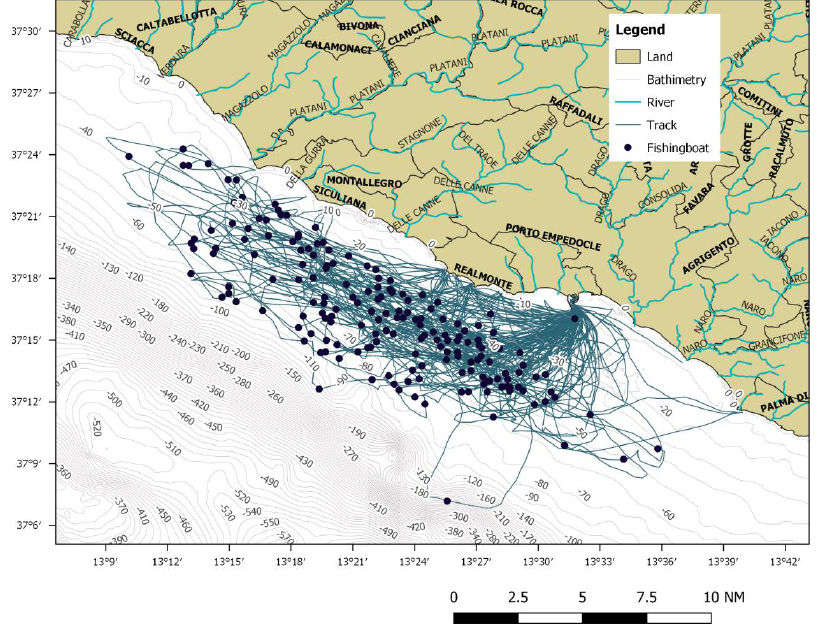
Figure 1. Geographical locations of fishing boats (blue dots, trawlers and pair trawlers) observed in the waters of the Agrigento province, in 2018 – 2019. Survey tracks are shown in light blue. Recorded sightings of seabirds were 674 for shearwaters and 92 for European storm petrels (Figure 2). Among the shearwaters, the Scopoli’s shearwater was the most fre- quently sighted.